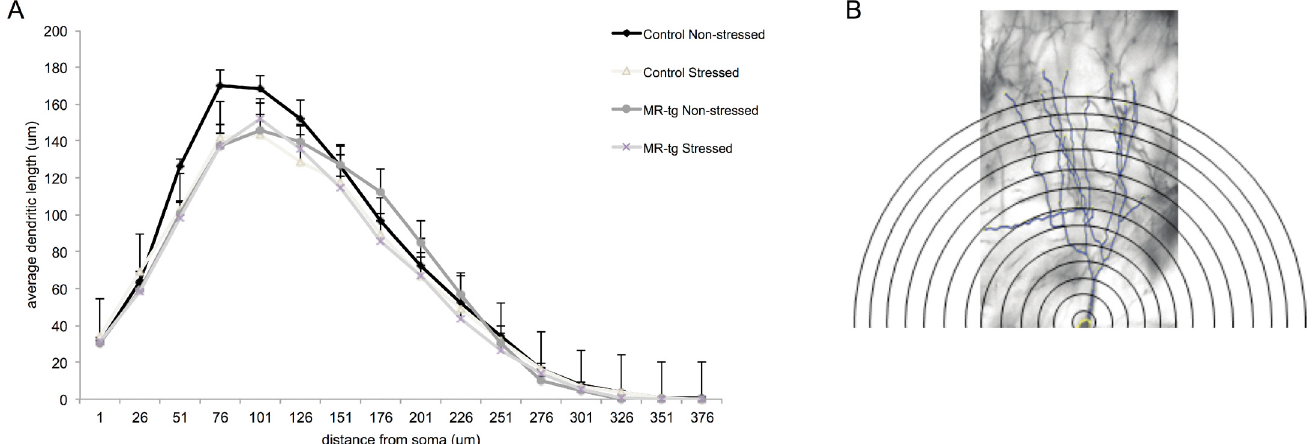
Fig 5. Sholl plots in stressed and non-stressed control and MR-tg mice. (A) The average dendritic length measured at specific distance points from the soma in all experimental groups. Analysis was based on the same cell groups as used in S2 Fig. Data are expressed as mean ± SEM. (B) Representative image of a CA3 pyramidal neuron analyzed at various bins representing the distance from the soma. We restricted the analysis to the apical dendrites only. Calibration bar: 20 μ